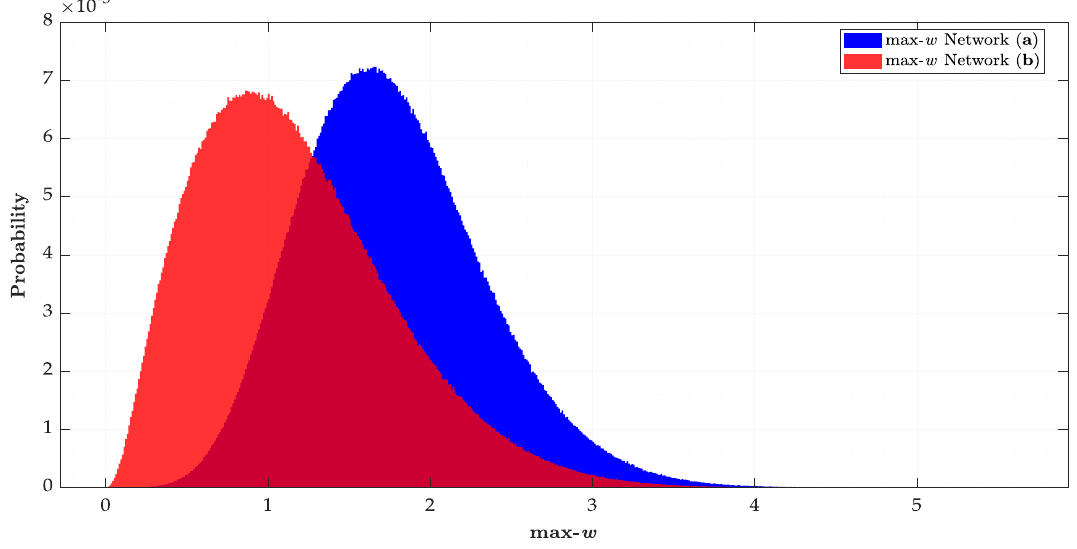
Figure 6. Probability histograms of max- w for networks ( a ) in blue and ( b ) in